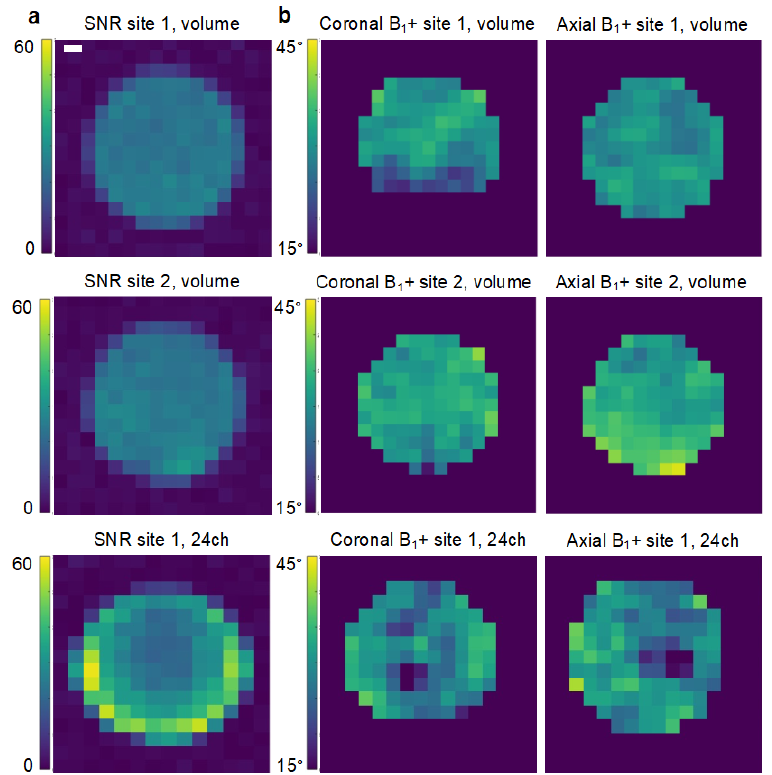
Figure 1. Comparison of the coils used at the two sites. The tests were performed on a natural abundance dimethyl silicone phantom by excitation of a single resonance with an echo-planar imaging readout. The signal-to-noise ratio (SNR, ( a )) was determined over a 5 min scan. The B 1+ profile ( b ) was determined using the double angle method. The white scale is 2 cm.